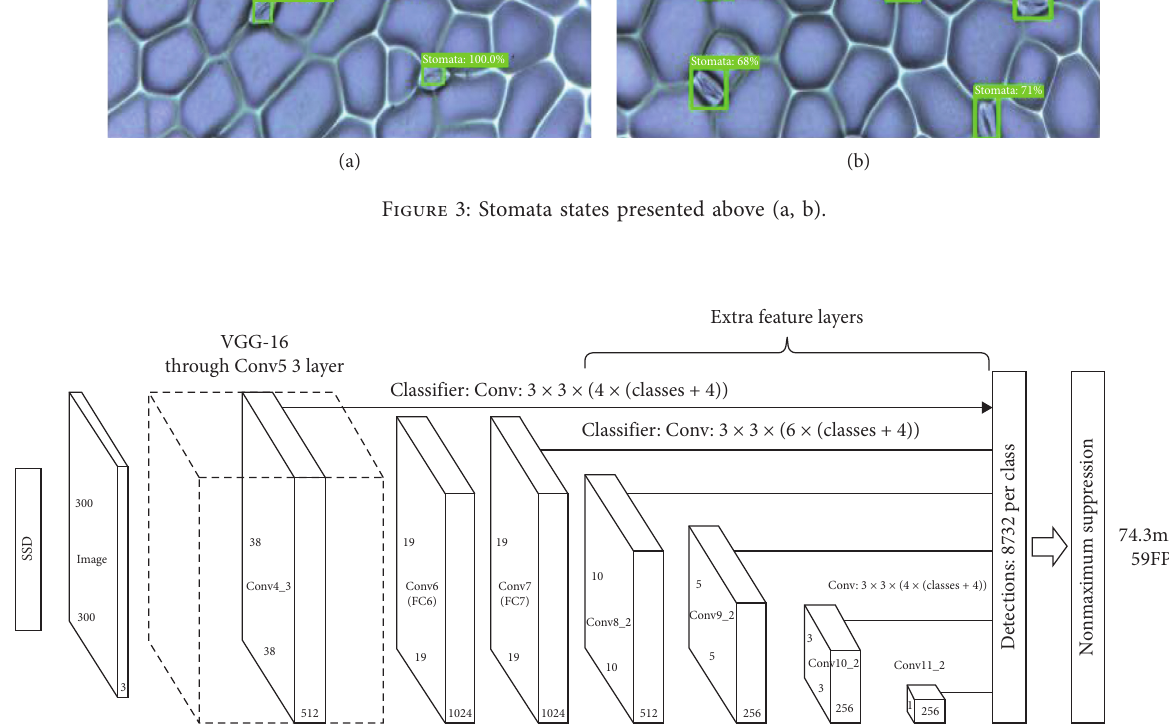
Figure 4: Architecture of SSD-MobileNet V2